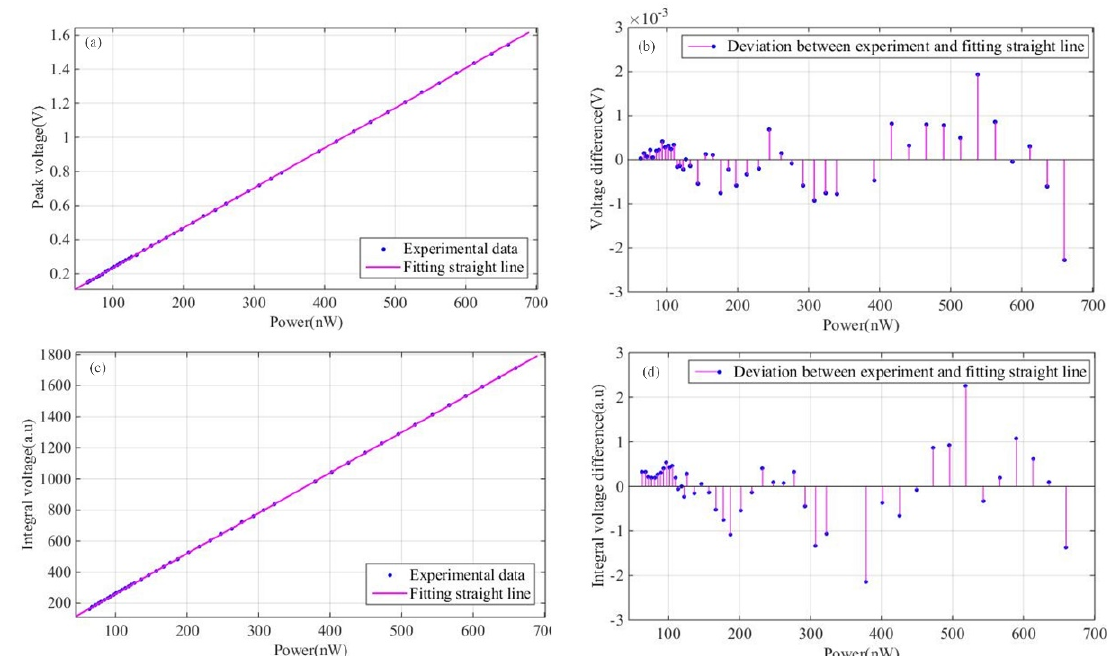
Figure 14. ( a ) Experimental data of output peak voltage of the optimized ACB varying with input power at magnification of 10 and its fitting straight line. ( b ) Voltage differences between experimental data and fitting straight line in Figure 14a. ( c ) Experimental data of output integral voltage of the optimized ACB varying with input power at magnification of 10 and its fitting straight line. ( d ) Integral voltage differences between experimental data and fitting straight line in Figure 14c.